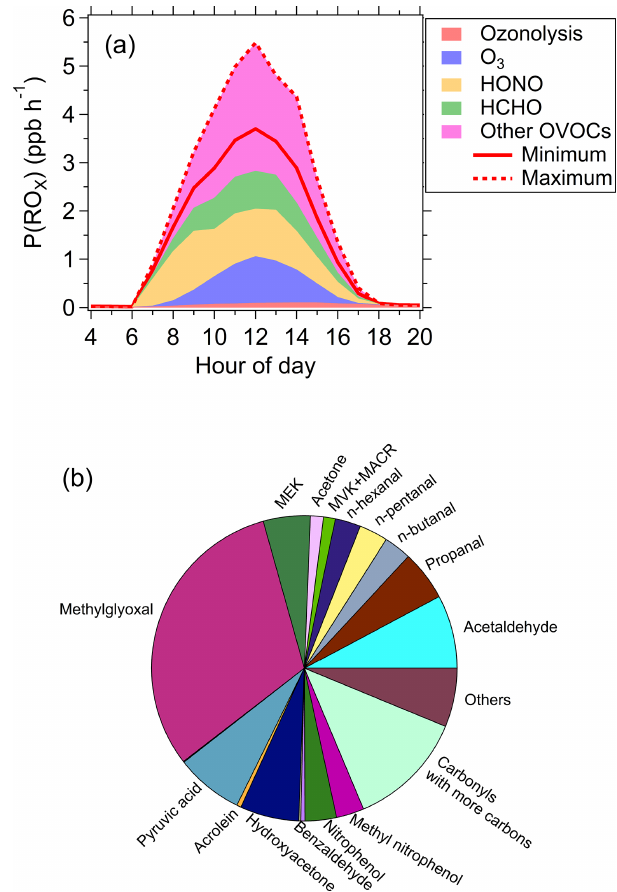
Figure 2. The P (RO x ) calculated by the box model with all ob- served photodegradable species constrained. (a) The source com- position of total P (RO x ) during the campaign; the solid and dashed lines represent the scenarios with minimum and maximum OVOC contributions to P (RO x ), respectively. (b) The relative contribu- tions of non-HCHO OVOC species to P (RO x ) for the scenarios with minimum OVOC contribution to P (RO x